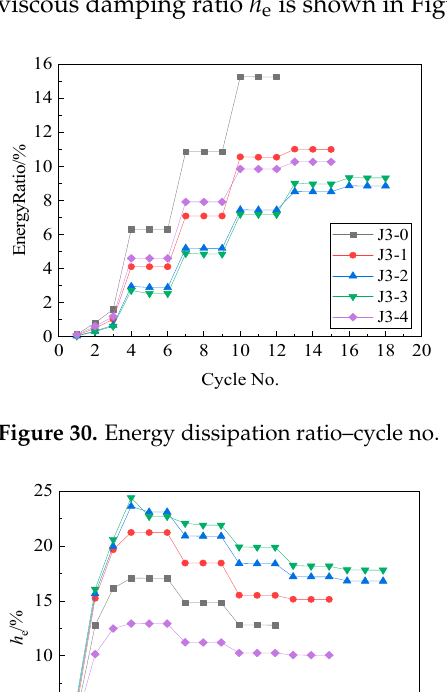
Figure 29. Comparison of joint failures: ( a ) J3-1; ( b ) J3-2; ( c ) J3-3; ( d ) J3-4. Energy Dissipation